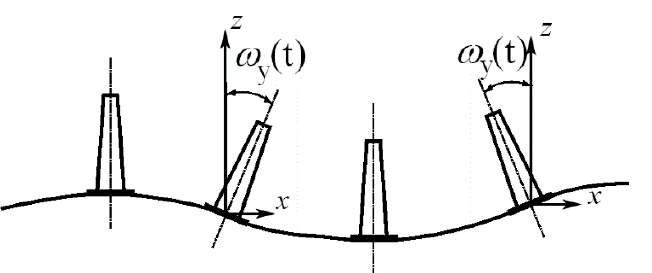
Figure 2. Rocking vibrations ω y ( t ) of a structure under wave passage excitations along the horizontal x -axis.